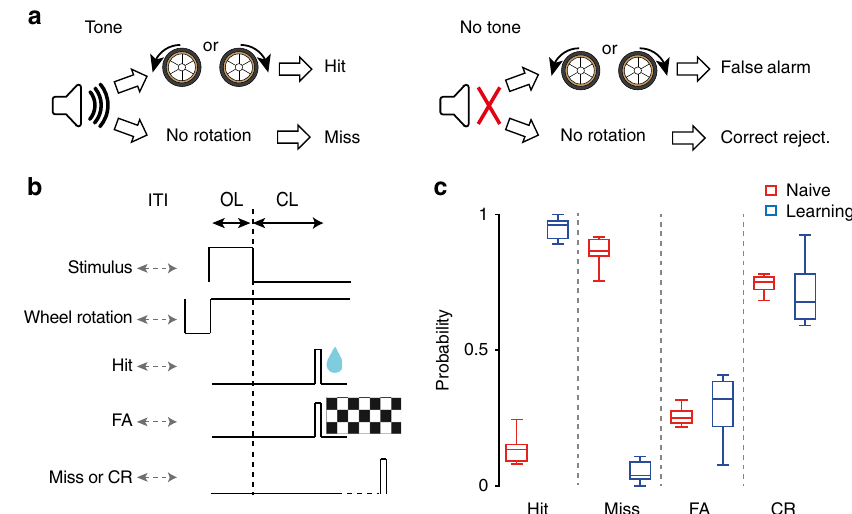
Fig. 4 Go-no-go auditory detection task. a Example trial: in 70% of the trials, the animal was presented with brief tones (left panel). Mice had to respond by rotating the wheel in either direction. In the remaining 30% of trials, no tone was presented and the mouse had to refrain from rotating the wheel (right panel). b Trial structure of reward and negative feedback; ITI inter trial interval (randomized), OL open-loop period, CL close-loop period. c Box-and- whisker plot comparing percentage of Hit, Miss, false alarm (FA), and correct rejection (CR) responses of a representative mouse for fi rst 10 sessions (Naive) and 15 consecutive sessions after the mouse reached a performance of d ′ > 1.5 (learning). The whiskers show the minimum and maximum of data distribution; box lines show the 25th percentile, the median, and the 75th percentile. In naive mice, FA rates are higher than Hit rates possibly due to a startle re fl ex following the target sound presentation ( P < 0.005, n = 10 sessions, Wilcoxon signed rank